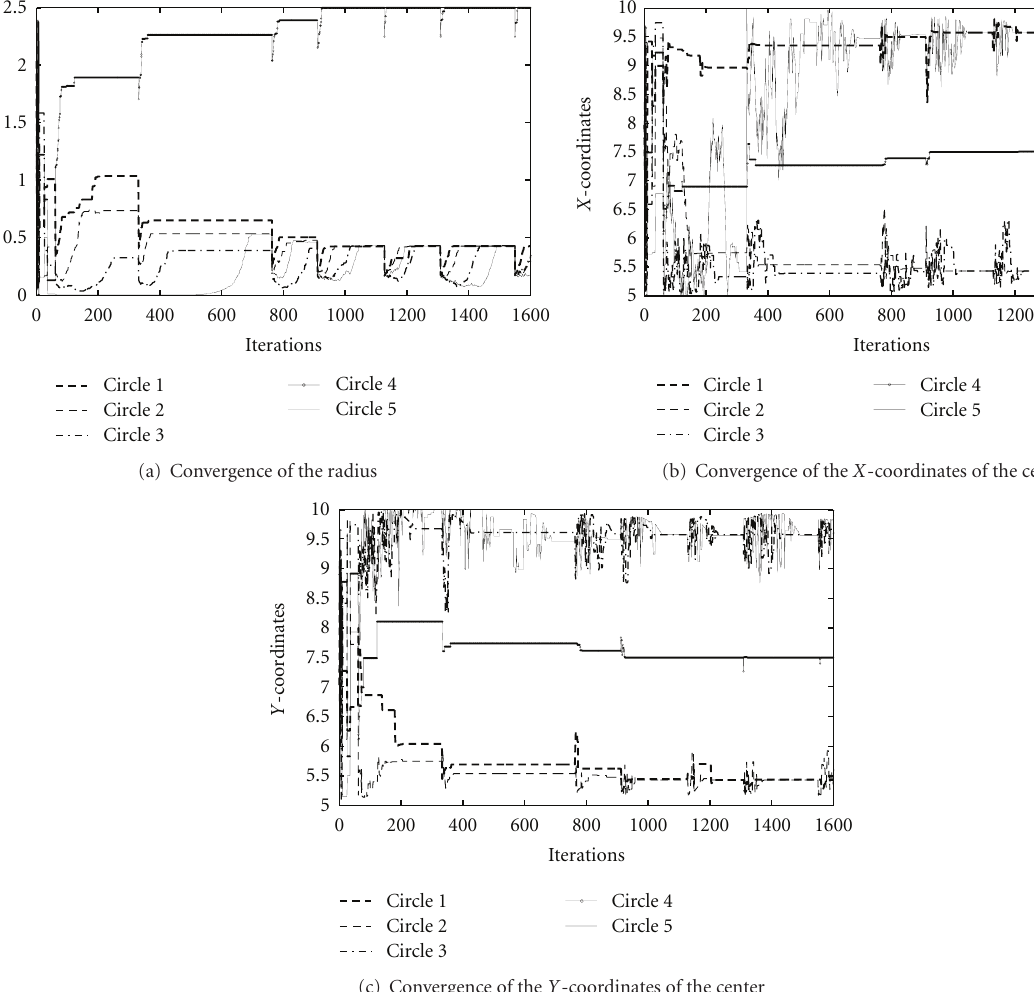
Figure 5: Convergence of the strategies of circle